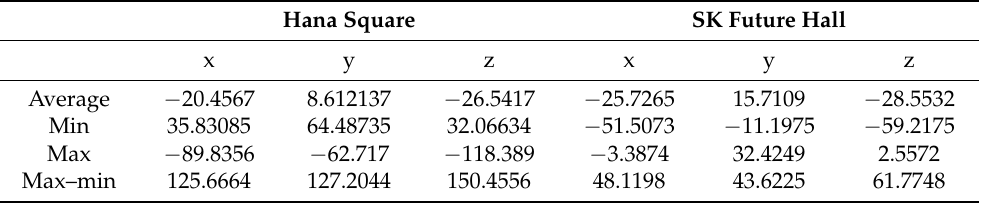
Table 3. Statistical characteristics (average, max, min, range) for x, y, z axis of the magnetic field maps. Hana Square SK Future